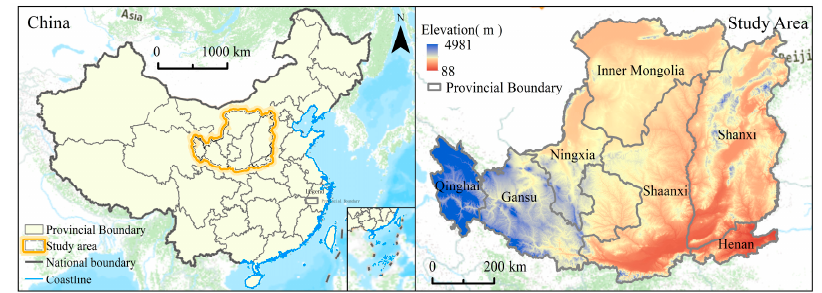
Figure 1. Location of the Loess Plateau.